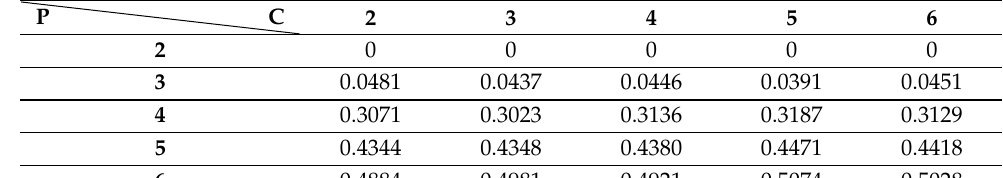
Table 6. Performance index of AGM that created context flexibly.